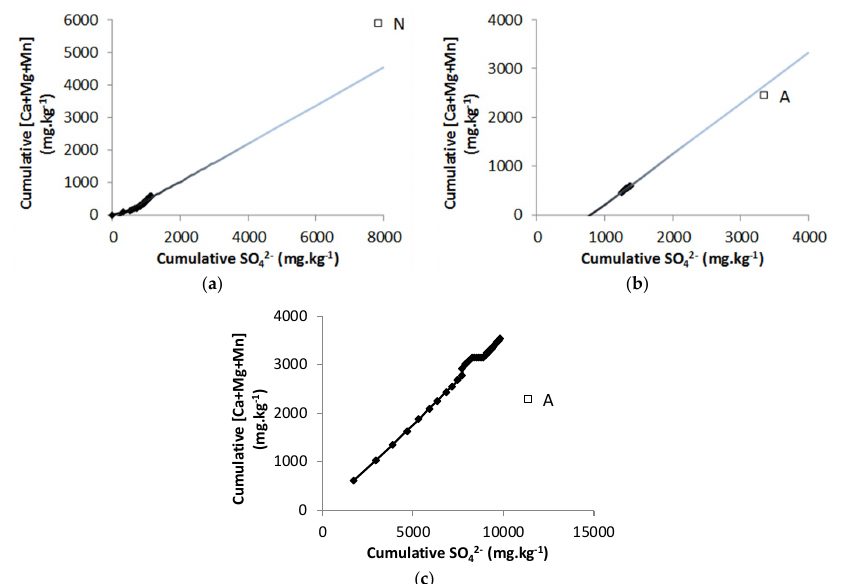
Figure 7. Extrapolation of the oxidation‐neutralization curves and projection of the samples initial compositions for ( a ) Kittilä, ( b ) Meliadine, and ( c ) Westwood. A: acid‐generating samples; N: neutralizing samples. For Kittilä, the initial composed projection is over the oxidation‐neutralization curve, which means that the sample contains neutralizing minerals in sufficient amount to neutralize the acidity generated by sulfide oxidation. In this case, the material should not be acid generating in the long‐term. This statement should be established by taking into account the ore’s texture and other mineralogical parameters than modal mineralogy. Contrariwise, for Meliadine and Westwood, the initial composition projections are under the oxidation‐neutralization curve. The samples would be acid generating in the long term, and thus the results of the static test would be relevant and the initial geochemical behavior of the two samples would not reflect the whole behavior in the long run. Lapa would be acid generating too, but according to the methods of Paktunc [25,51], it would be classified as uncertain. Canadian Malartic and Pinos Altos will be uncertain. Only the Goldex wastes will be classified as not acid generating.